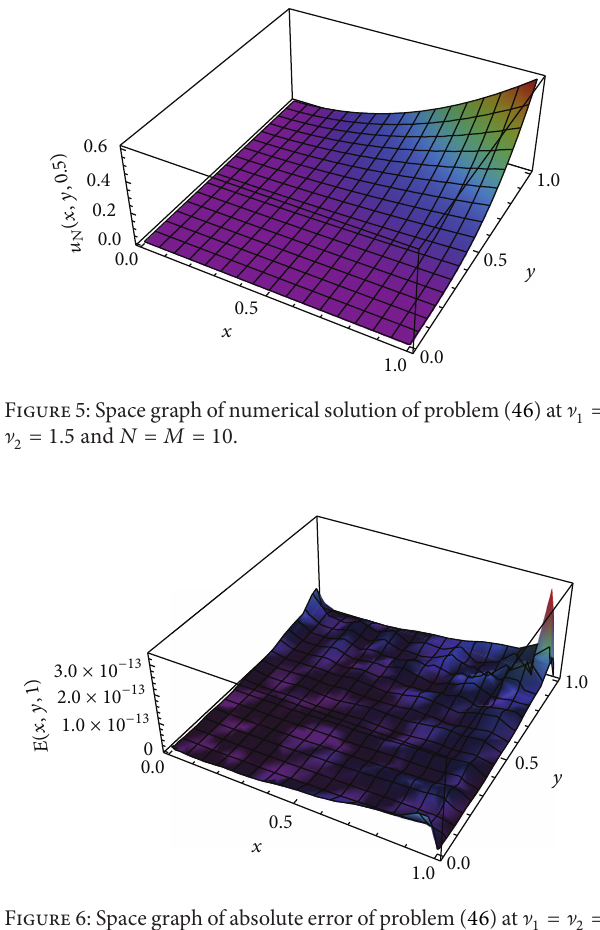
Figure 6: Space graph of absolute error of problem (46) at ] 1 = ] 2 = 1.5 and 𝑁 = 𝑀 = 10 .